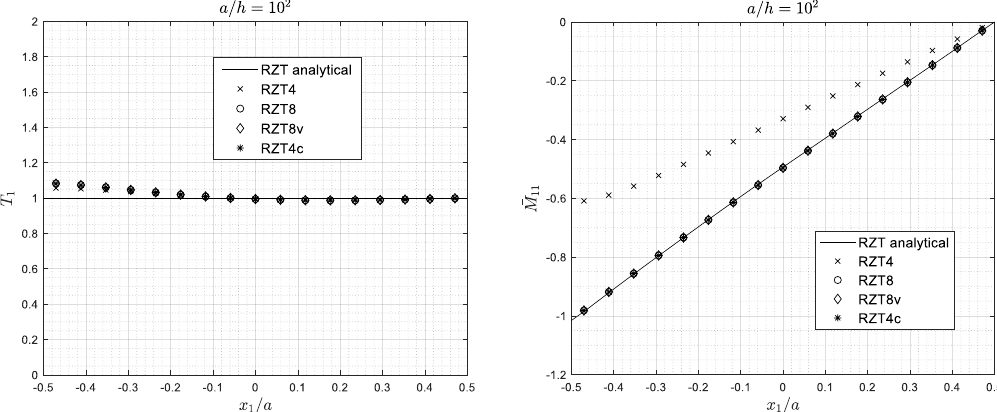
Figure 17. Cantilever thin sandwich (S) square plate under uniform edge transverse pressure (C2). Transverse shear force and bending moment distribution.